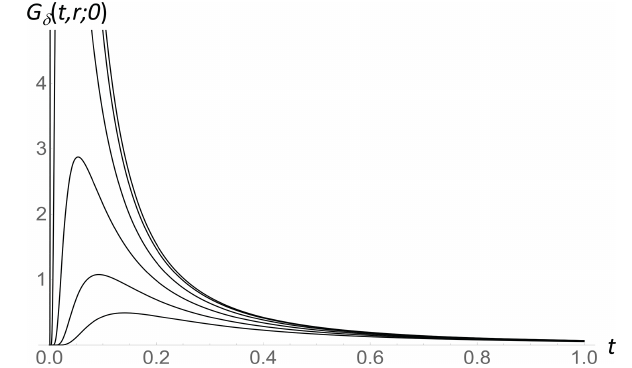
Figure 1. The surface impulse response function ( G δ ( t,r ; 0) in Eq. 12, i.e., Dirac in time and Dirac in space) as a function of nondi- mensional time ( t ) for nondimensional distance from the source in- creasing from r = 0 (top) to r = 1 in steps of 0.2 (top to bottom).